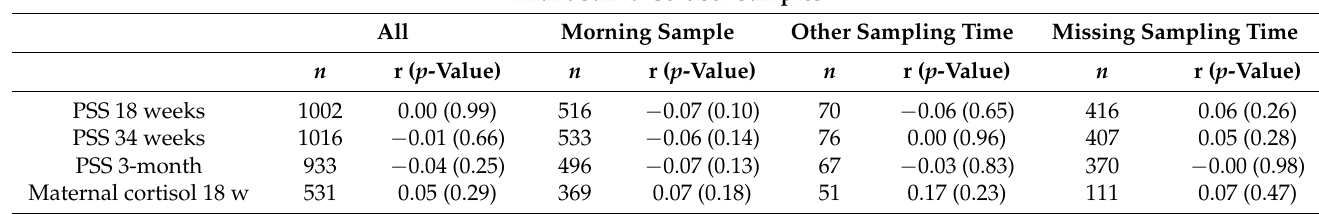
Table 2. Spearman non-parametric correlations between infant cortisol at three months and maternal perceived stress in pregnancy at 18-, 34 weeks, and at three months infant age and maternal cortisol (18 w). Groups represent infants with All infant saliva cortisol (All iSC) regardless of sampling time ( n = 1057); Morning sample (05–10:59, n = 551); Other sampling time from 11 am (until 04:59 pm, n = 79); Missing sampling time (no stated time of sampling, n =